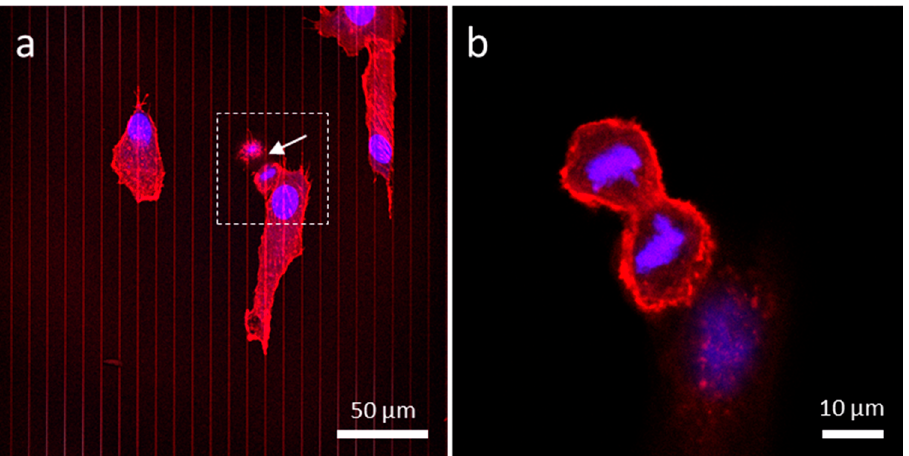
Figure 9. ( a ) A dividing cell possibly in telophase on the structure containing 1 µm tungsten and 9 µm silicon oxide lines. Other cells in the interphase stage are aligned with the line axes. ( b ) High magnification of the dividing cell highlighted in ( a ). It shows that the dividing cell is near spherical in shape and not aligned to the line axes.